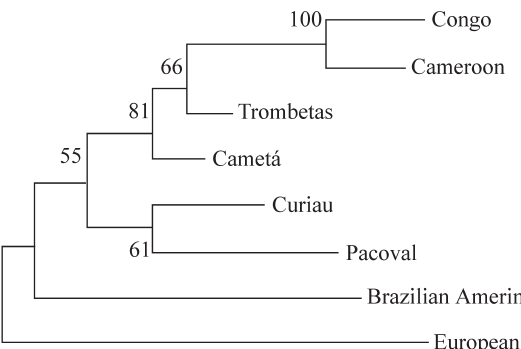
Figure 1 - Dendrogram constructed by neighbor-joining method, showing the relationships among Pacoval, Curiau and other Afro-Brazilian com- munities, Cameroon, Congo, European and Brazilian Amerindians, based on allele frequencies of the autosomal hypervariable loci studied.